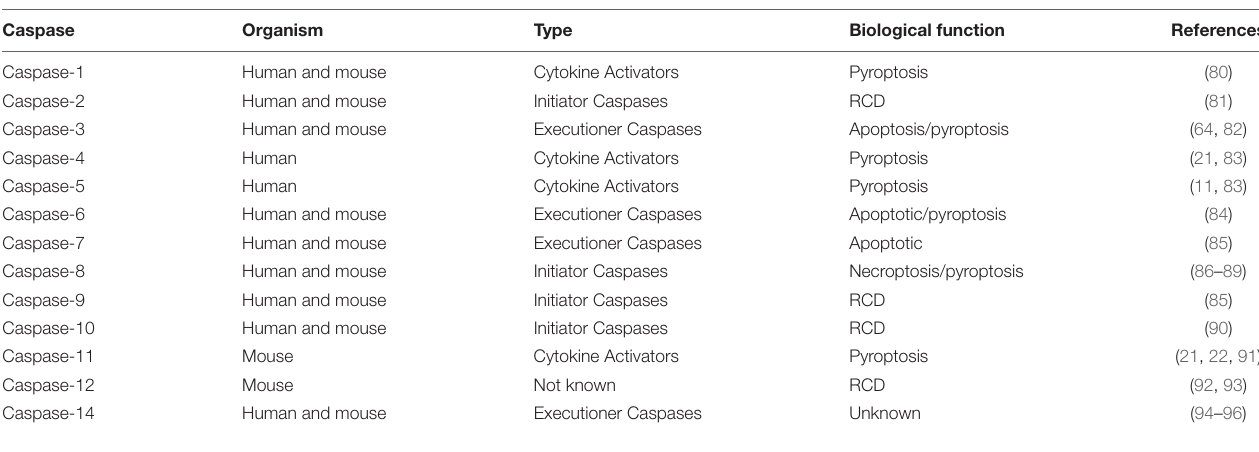
TABLE 2 | Key information of caspase